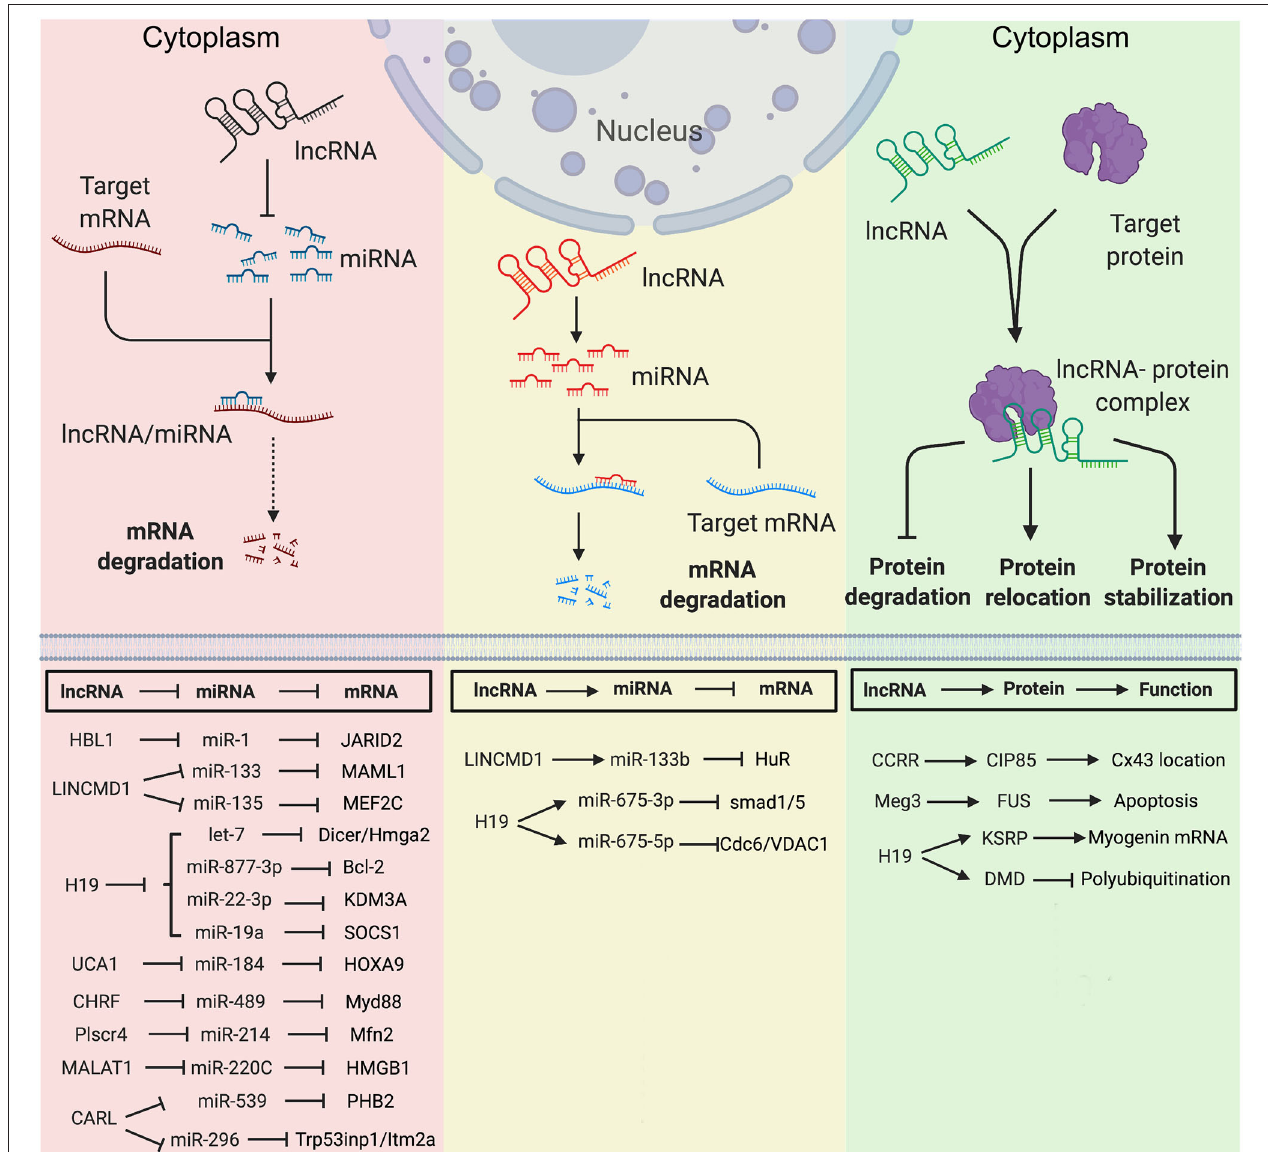
FIGURE 1 | Mechanisms of Long non-coding RNAs in cytoplasm in heart development and diseases. (Left) lncRNA functions as miRNA sponge. (Middle) lncRNA functions as miRNA precursor. (Right) lncRNA functions as protein scaffold. Created with